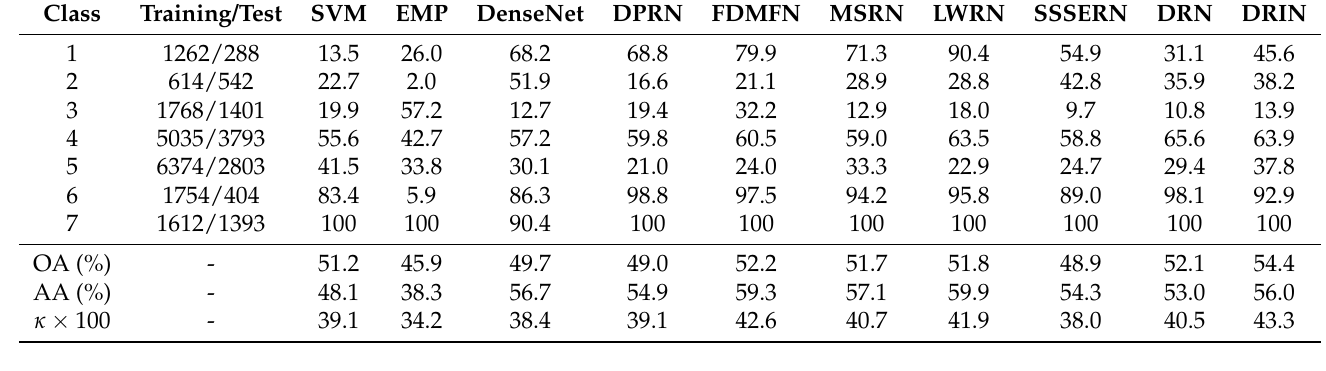
Table 12. Classification results for the HyRANK dataset.